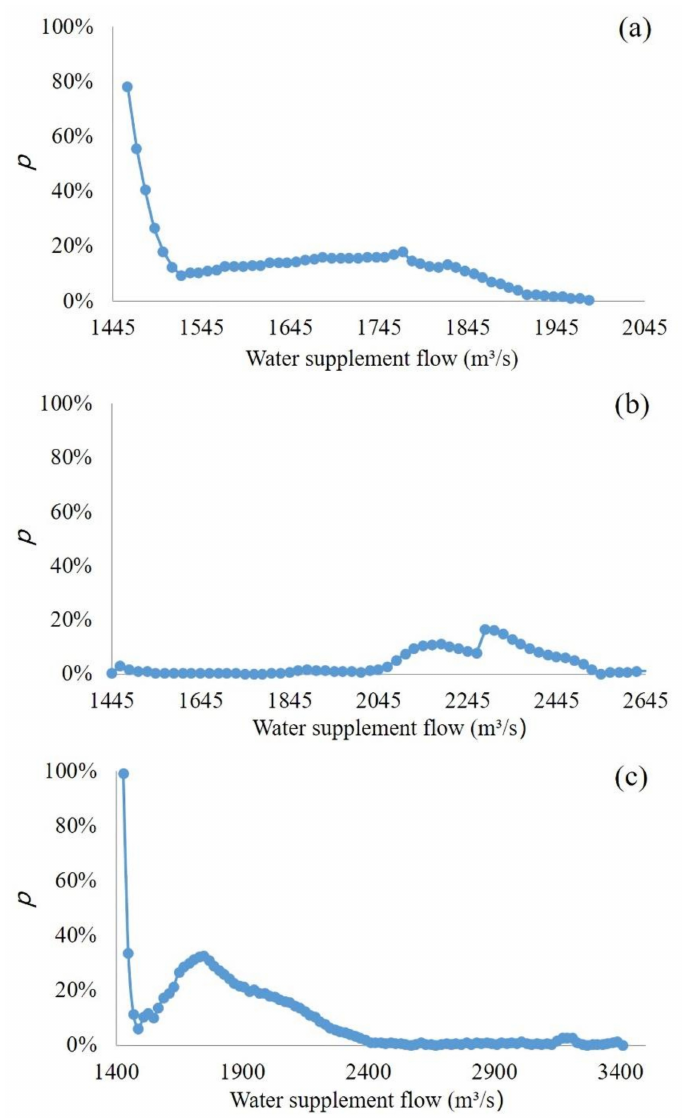
Figure 12. Effect evaluation of “collaborative independent” joint optimization. ( a ) April 1997, ( b ) March 1999, ( c ) March